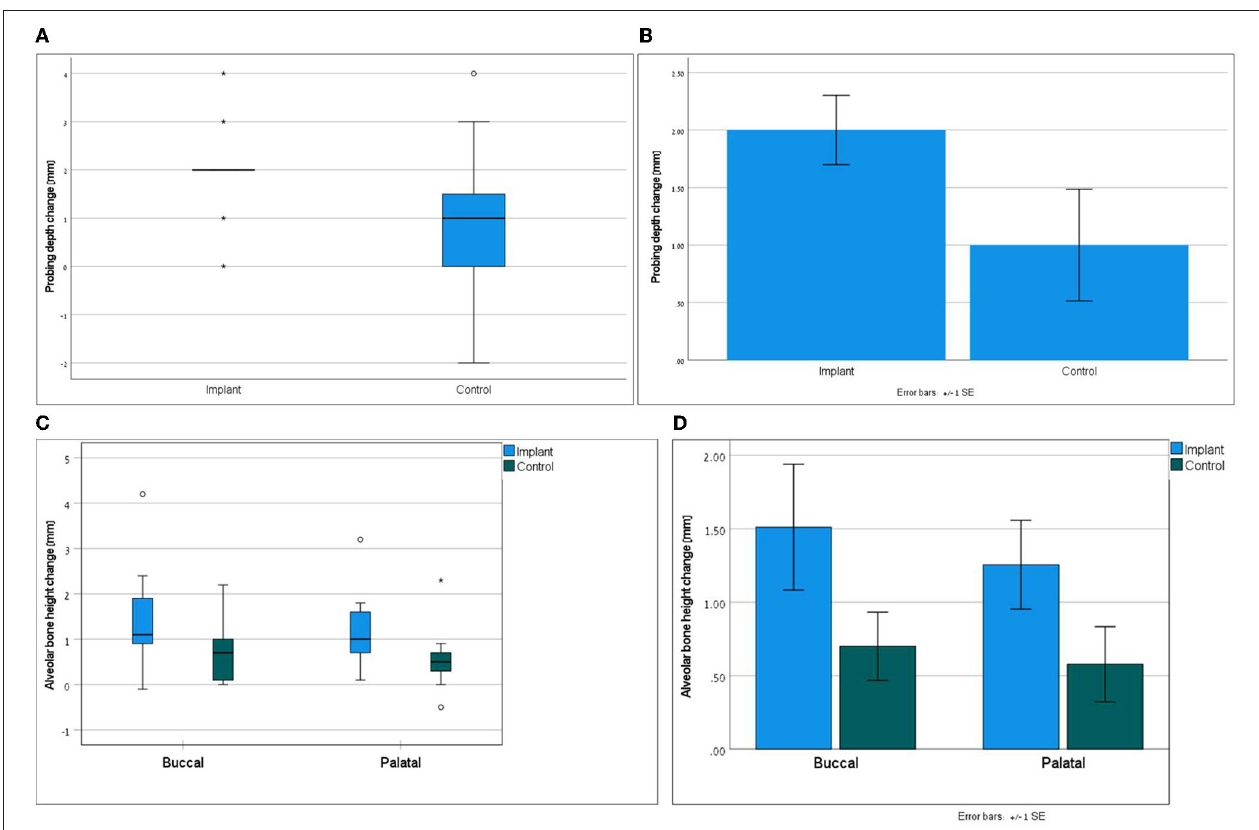
FIGURE 1 | Part (A) demonstrates the non-parametric distribution of probing depth; Wilcoxon signed ranks test; p = 0.026. Part (B) presents the mean differences of probing depth between the groups; paired t -test with normality assumption; p = 0.024. Part (C) demonstrates the non-parametric distribution of alveolar bone height; Wilcoxon signed ranks test; p = 0.017 for buccal and p = 0.093 for palatal. Part (D) presents the mean differences in alveolar bone height between the groups; paired t- test with normality assumption p = 0.009 for buccal and p = 0.097 for